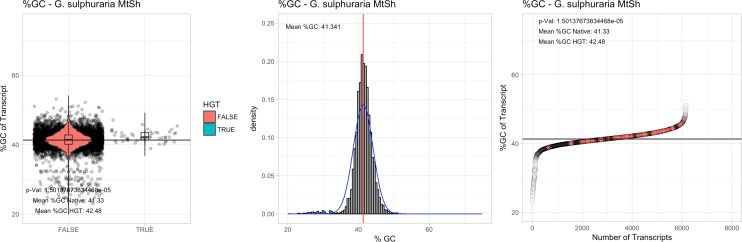
%GC – Galdieria sulphuraria Mount Shasta (MtSh): (Left) Violin plot showing the %GC distribution across native transcripts and HGT candidates.(Mid) Cumulative %GC distribution of transcripts. Red line shows the average, blue line a normal distribution based on the average value. (Right) Ranking all transcripts based upon their %GC content. Red ‘*' demarks HGT candidates. As the %GC content was normally distributed, students test was applied for the determination of significant differences between the native gene and the HGT candidate subset.